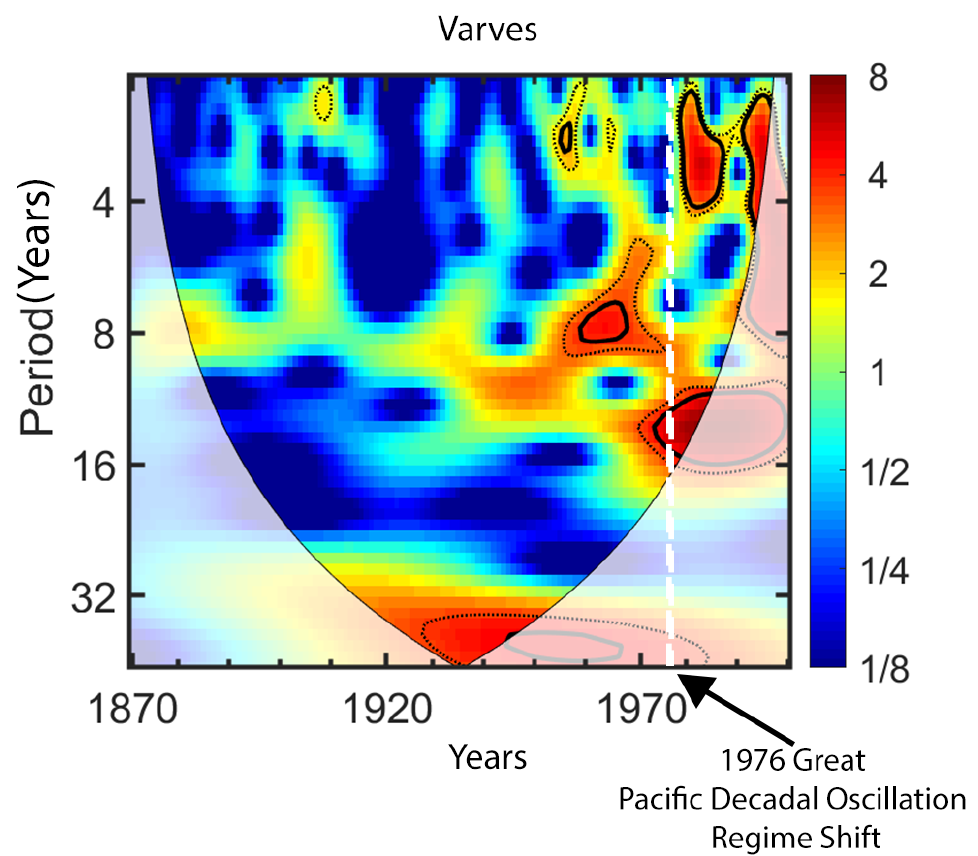
Figure 12. Annual wavelet transform highlighting 1976 PDO regime shift.